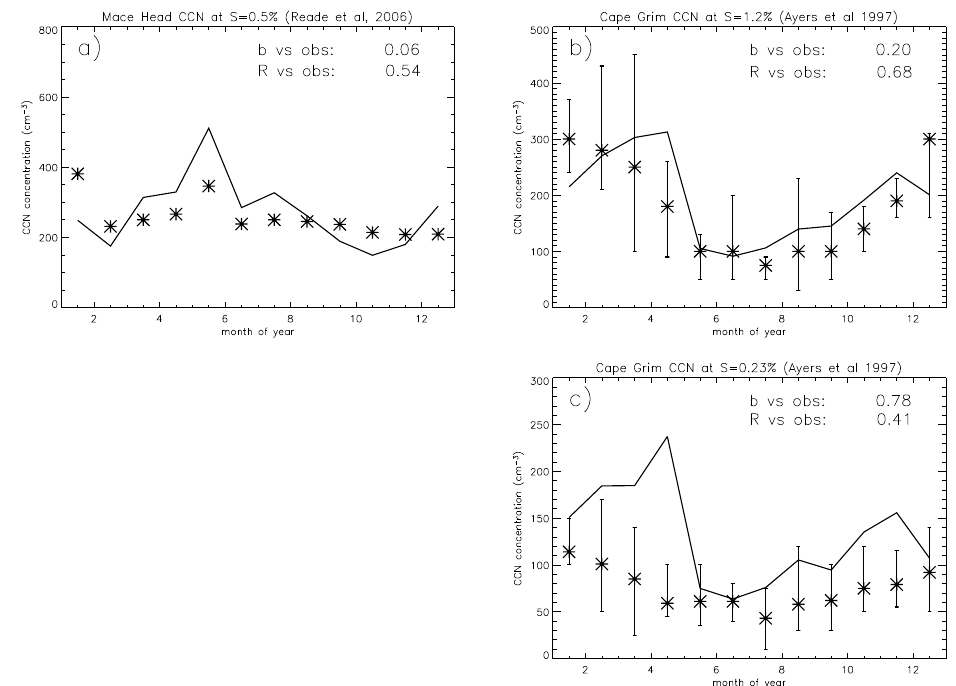
Fig. 22. The simulated annual cycle of CCN concentrations (solid lines) against observations (asterisks) at Mace Head and Cape Grim. The measurements at Mace Head (a) are with 0.5% superstaturation whilst the comparison at Cape Grim is shown for measured CCN concentrations at supersaturations of (b) 1.2% and (c) 0.23%. Vertical bars around the Cape Grim observations show the observed range from 1981–1989 (Ayers and Gras,